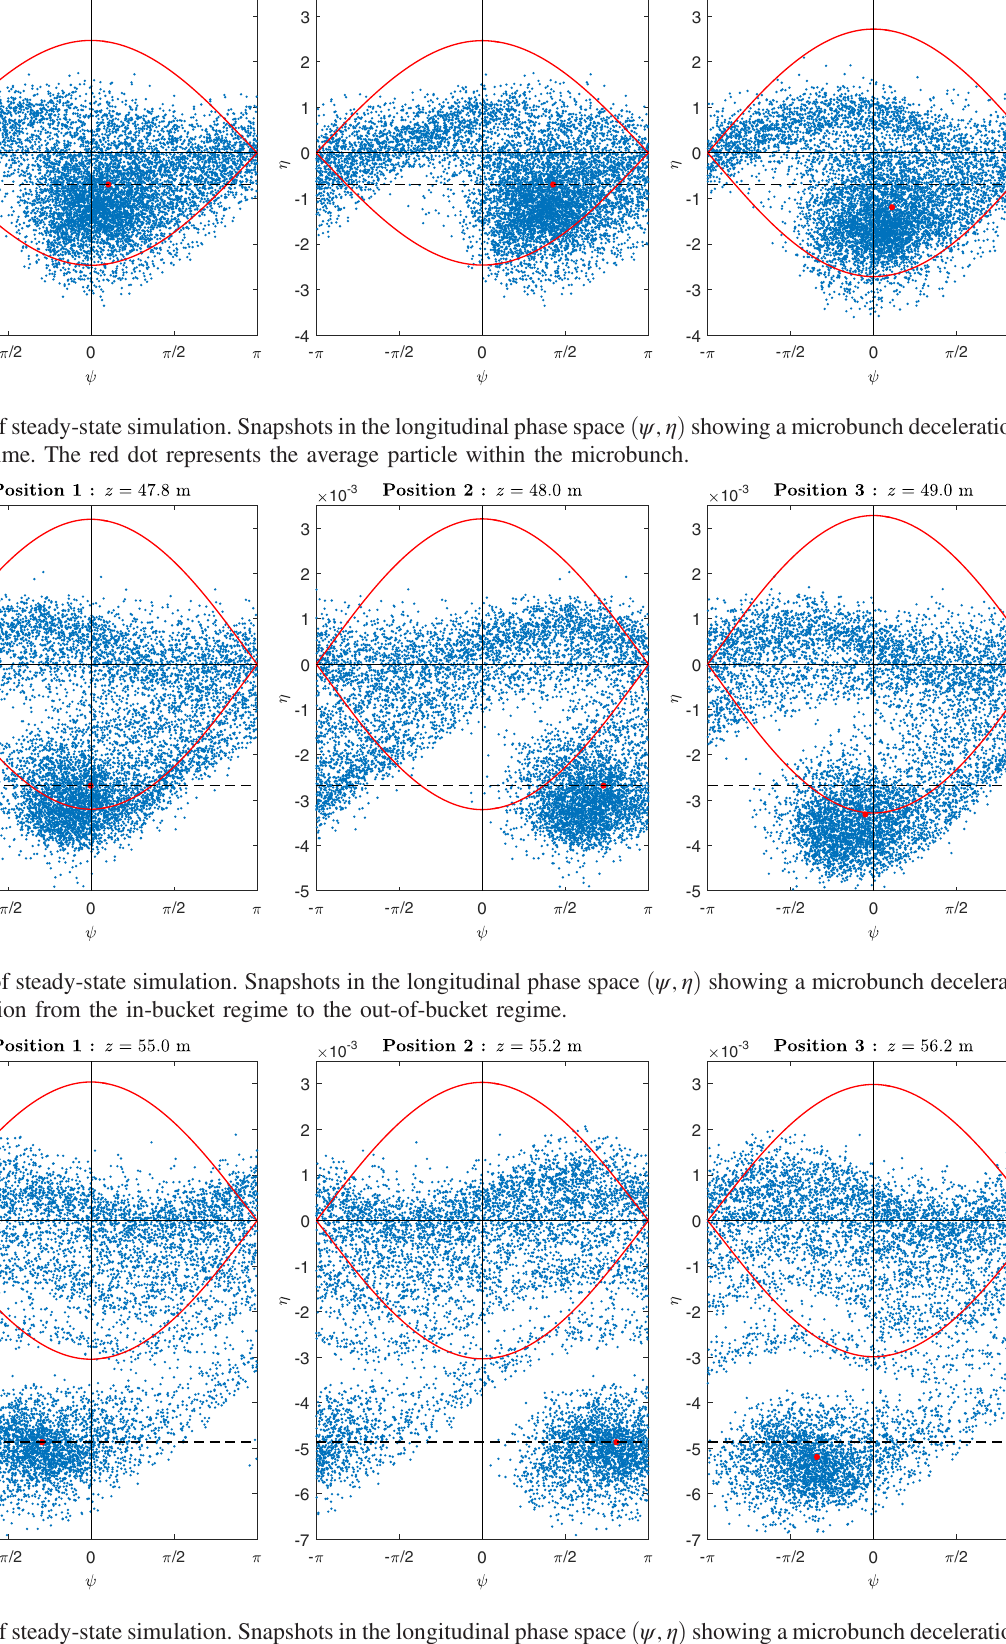
FIG. 8. Result of steady-state simulation. Snapshots in the longitudinal phase space ð ψ ; η Þ showing a microbunch deceleration cycle at the onset of the final saturation